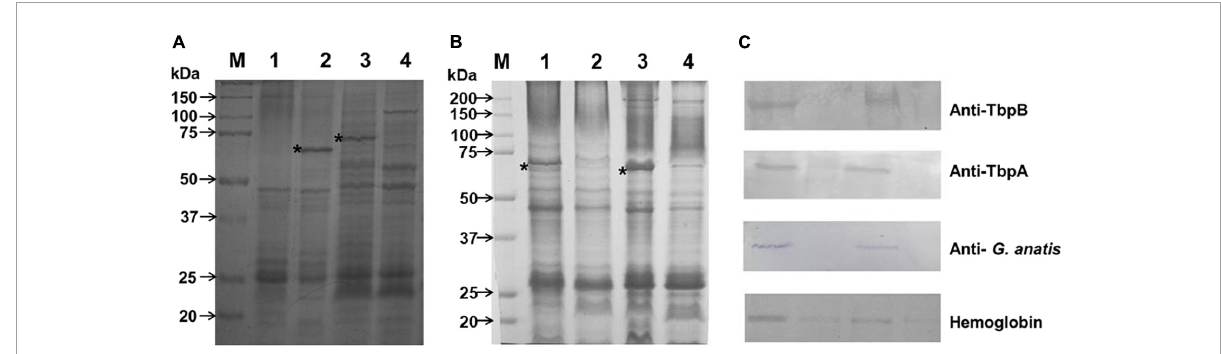
FIGURE2 Up and down expression of proteins due to iron depletion. (A) Triton-insoluble (lanes 1 and 2) and Triton-soluble (lanes 3 and 4) proteins from G. anatis 12656-12 were separated by electrophoresis on 10% polyacrylamide gels and stained as described under Material and methods. The bacterium was grown under iron-restricted conditions (lanes 2 and 4) or normal conditions (lanes 1 and 3); the 65-kDa and 70-kDa proteins are shown in lanes 2 and 3, respectively (*). (B) Differential expression of the 65-kDa protein when G. anatis F149 T (lanes 1 and 2) or 12656-12 (lanes 3 and 4) were grown under iron-restricted (lanes 1 and 3) or normal conditions (lanes 2 and 4). *Indicates 65- kDa protein in Triton-insoluble samples. (C) Immunological recognition of the 65- kDa iron-restricted protein from G. anatis F149 T and 12656-12 by polyclonal sera against TbpB and TbpA proteins, both from A. paragallinarum , or by pooled sera from chickens infected with G. anatis ; or interaction with biotinylated chicken hemoglobin.